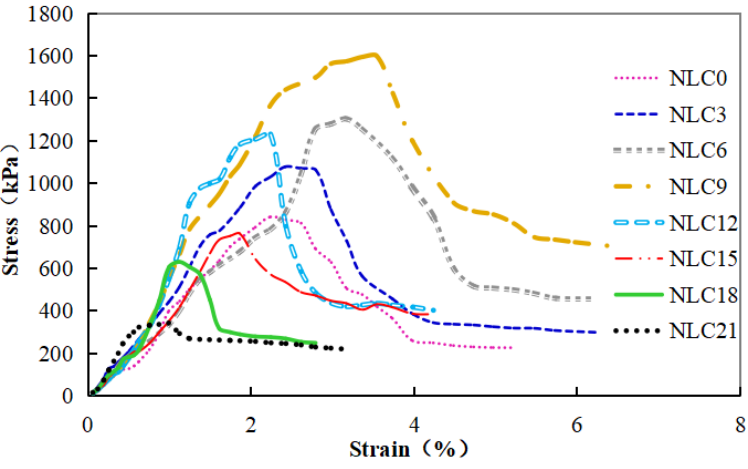
Figure 4. Stress-strain curves of MICP treated sand with different clay content. Stage 1: A small range of strain variation and sharp increase in stress. The interaction between calcium carbonate and sand particles connects the sand column to the whole through the “connecting bond” between calcium carbonate and sand particles to bear the pressure together. At this stage, the variation range of the strain is small, and the